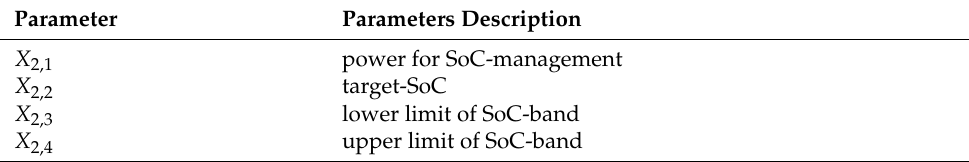
Table A1. Parameters X 2 of function F 2 .